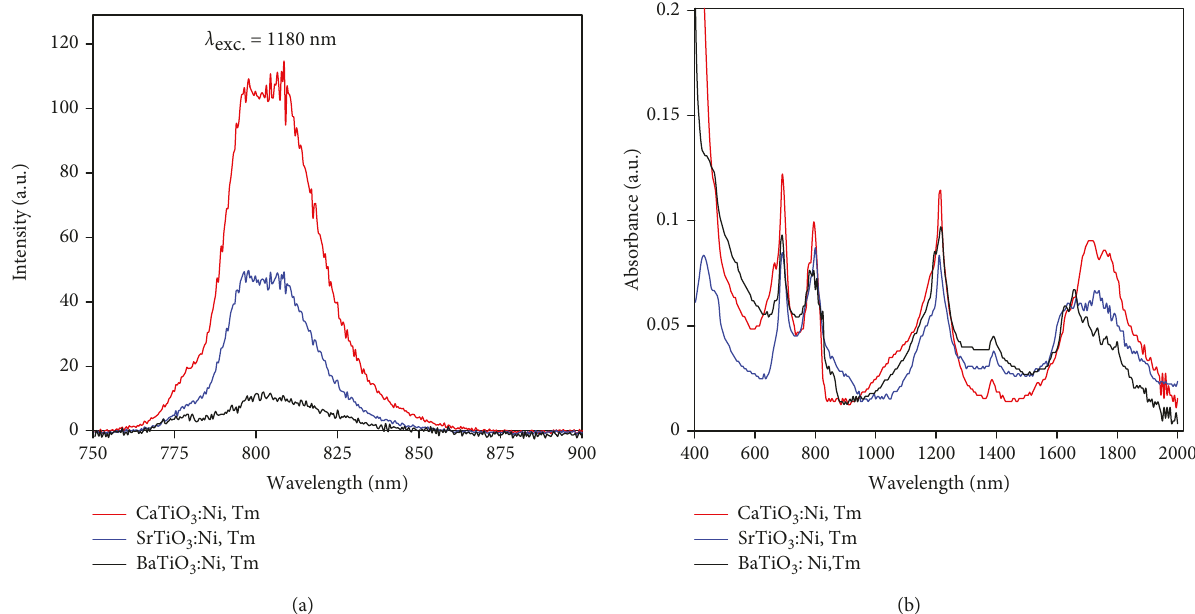
Figure 8: (a) UC emission and (b) absorption spectra of the (Ca/Sr/Ba)Ti